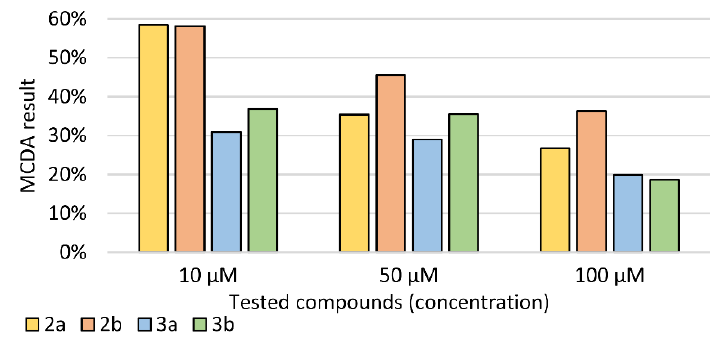
Figure 8. Multiple-criteria decision analysis (MCDA) of the e ff ect of the tested pyridazinone derivatives; MCDA was calculated based on E / E LPS ratios determined in individual assays, where E is the sample result, and E LPS is the result in control preincubated with LPS.